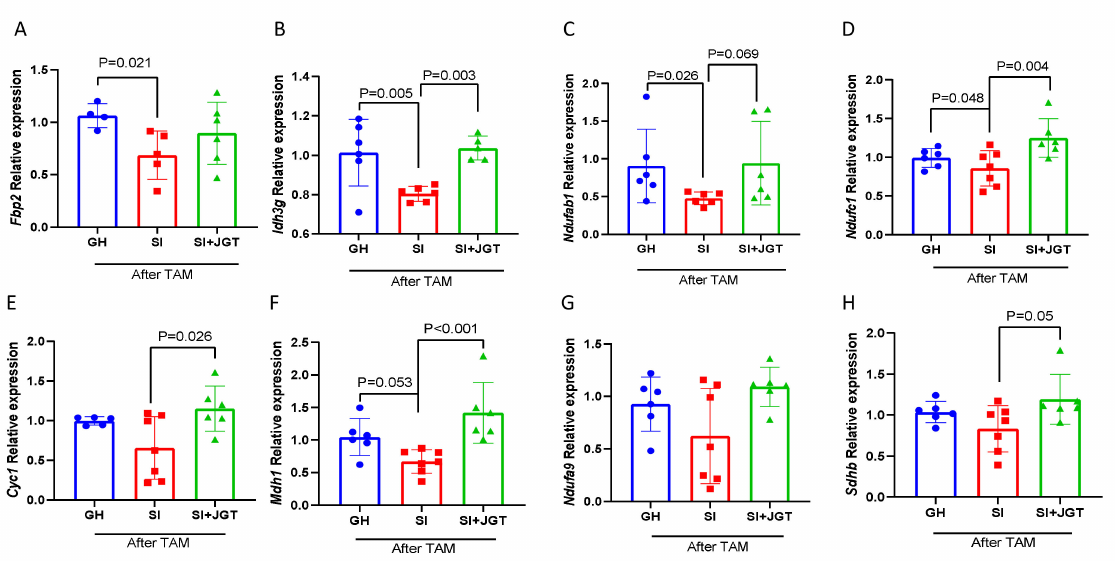
Figure 6. Effect of social isolation (SI) and Jaeumganghwa-tang (JGT) on OXPHOS genes that were suppressed in RNA-Seq analysis in the post-tamoxifen (TAM) mammary glands. Expression of ( A ) Fbp2 , ( B ) Idh3g , ( C ) Ndufab1 , ( D ) Ndufc1 , ( E ) Cyc1 , ( F ) Mdh1 , ( G ) Ndufa9 , and ( H ) Sdhb in